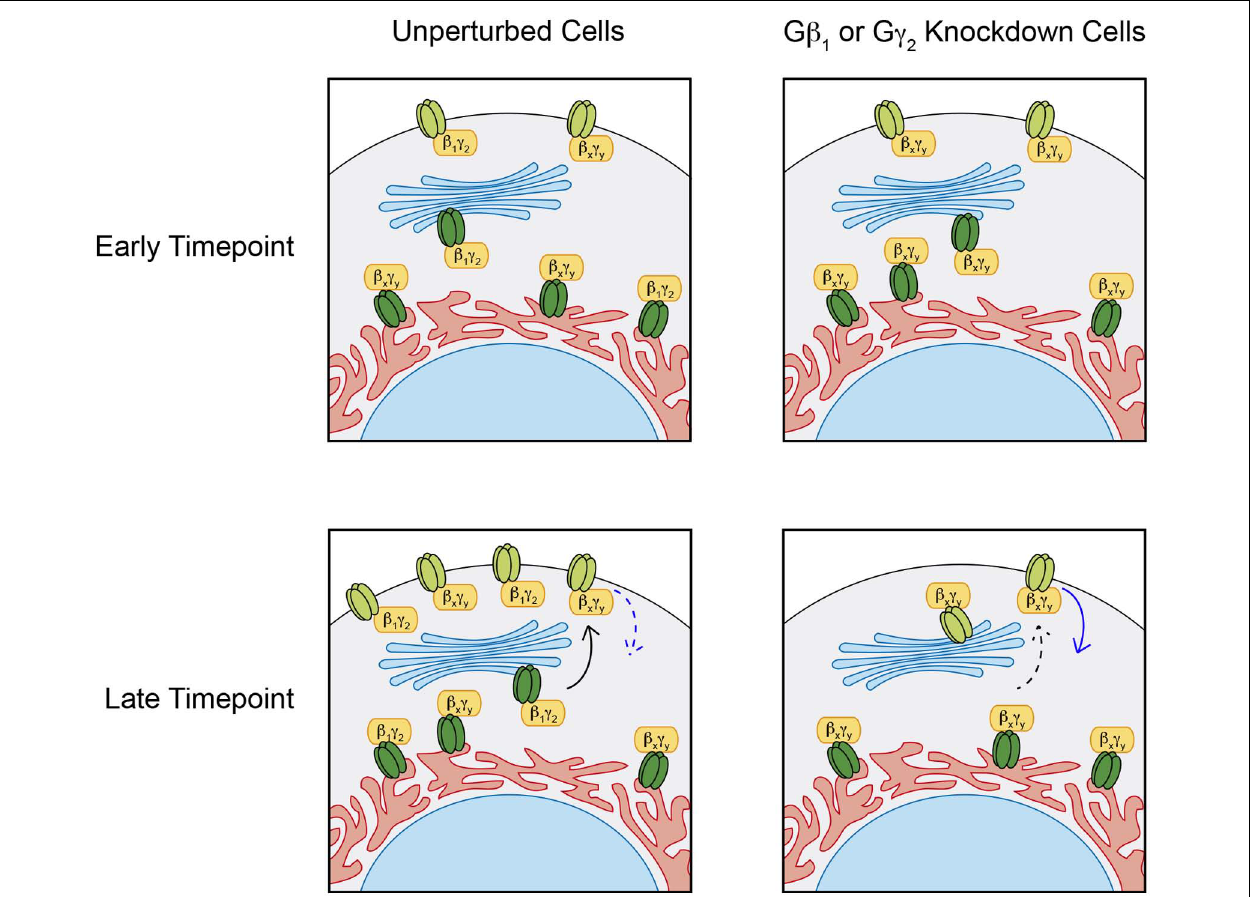
knockdown can be mediated through reduced anterograde trafficking (dashed black arrow) and/or enhanced channel internalization (solid blue arrow). Regardless of the G βγ pair associated with Kir3 channels in the ER, these are trafficked out to the cell surface. However, those associated with G β 1 γ 2 seem to persist longer than those associated with other G βγ combinations. This suggests that additional functions exist for some G βγ combinations, independent of their ability to open the channel in response to GPCR